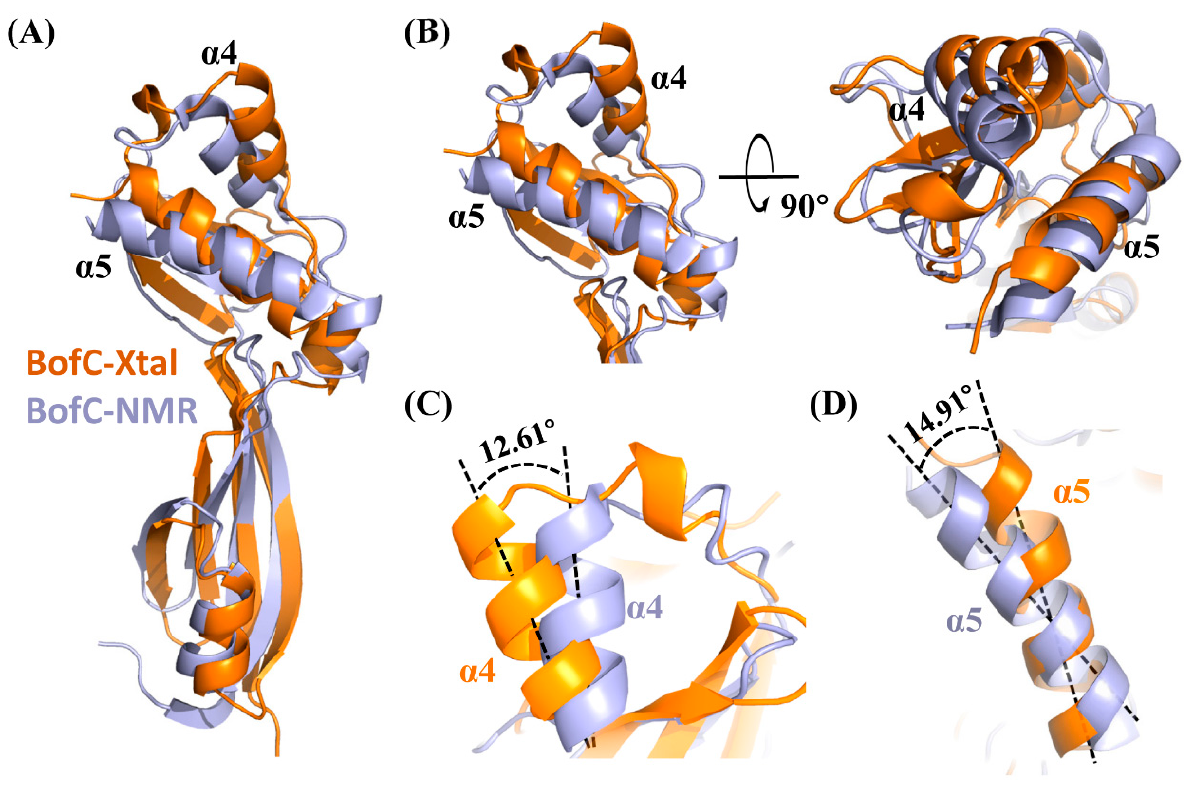
Figure 3. Comparison of BofC structures determined by the X-ray crystallography (BofC-Xtal, colored in orange) and NMR (BofC-NMR, colored in lightblue). ( A ) Overall, BofC-Xtal and BofC-NMR have similar structures (RMSD = 2.63 Å). ( B ) Two views of representation of domain 1 in BofC; there are some different conformations of α 4 and α 5 in domain 1. ( C ) The α 4 helix in the BofC-Xtal structure tilts about 12.61 ◦ compared to that in the BofC-NMR structure. ( D ) The α 5 helix in the BofC-Xtal structure tilts about 14.91 ◦ compared to that in the BofC-NMR structure.